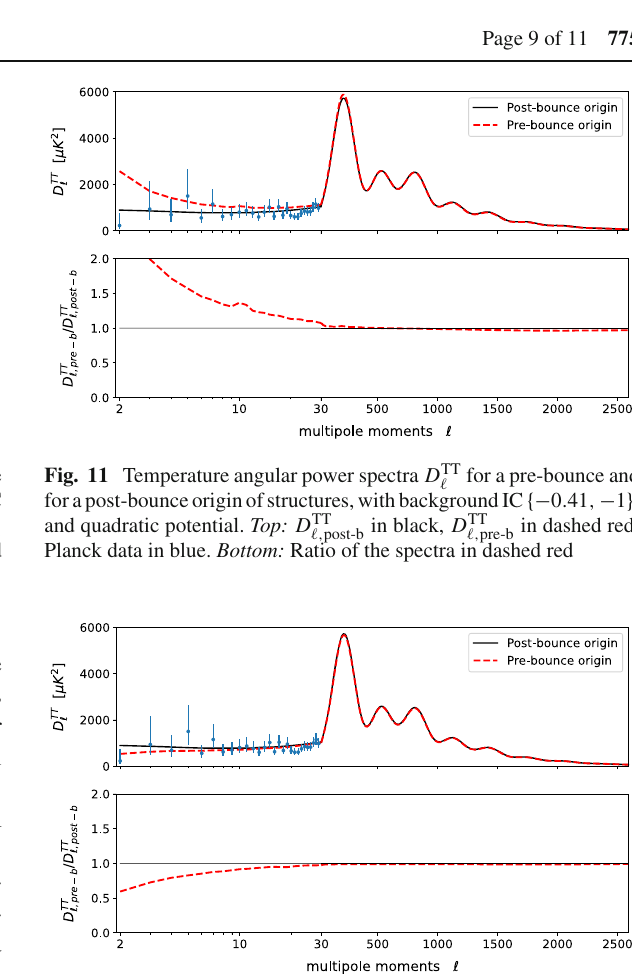
in black, D TT (cid:16), in dashed post-b pre-b